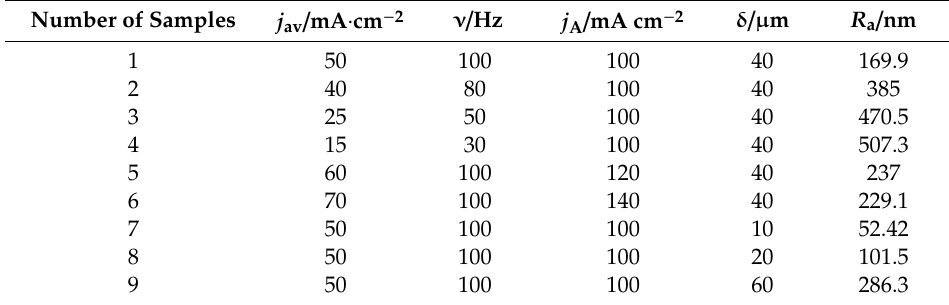
Table 5. The values of R a roughness obtained by the PC regimes under di ff erent electrodeposition conditions; δ —the thickness of coating.